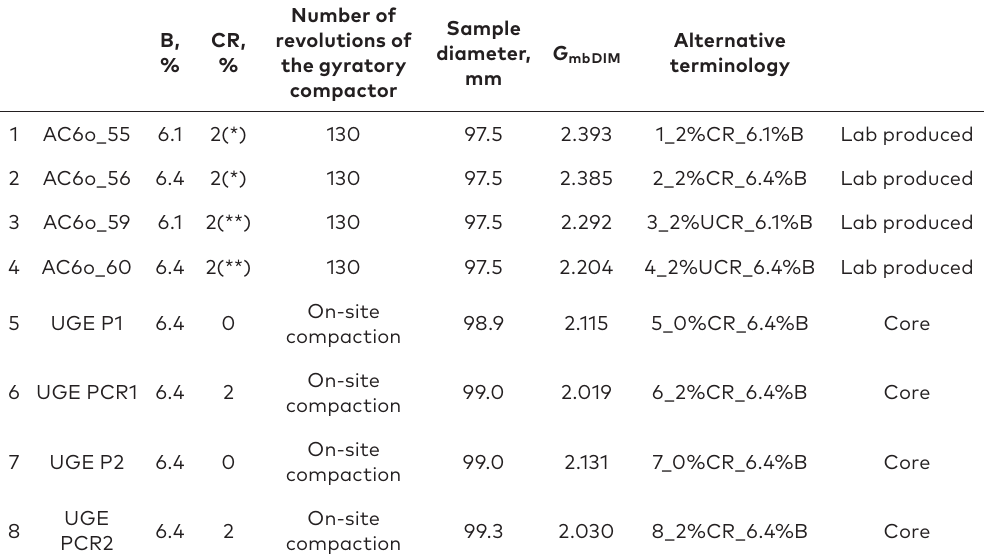
Table 3. Main characteristics of the tested samples